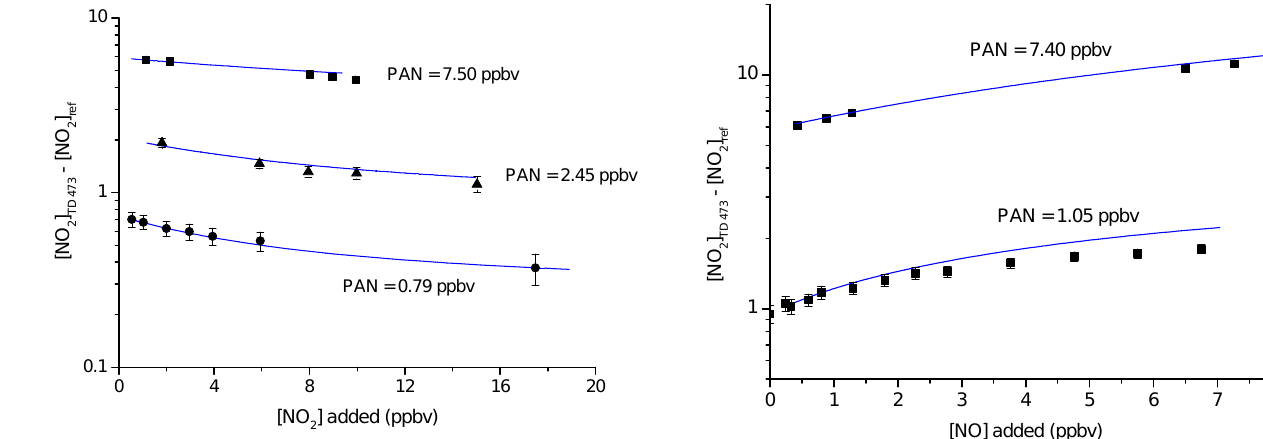
Figure 8. Measurements of the difference signal (TD cavity sam- pling from the 473K inlet – NO 2 reference cavity) with various amounts of NO added and at two different PAN concentrations (0.74 and 7.40ppbv). The error bars represent standard deviation and were derived by propagating errors in the NO 2 signals in the TD and reference cavities. The blue lines show the numerical simulations as described in Sect. 2.1.7. The apparent worsening of the agreement between the model and the experiment at [NO]>2.5ppbv is the re- sult of drifts in the PAN mixing ratio during this experiment. By normalising to the PAN concentration (as in Fig. 10), the deviation